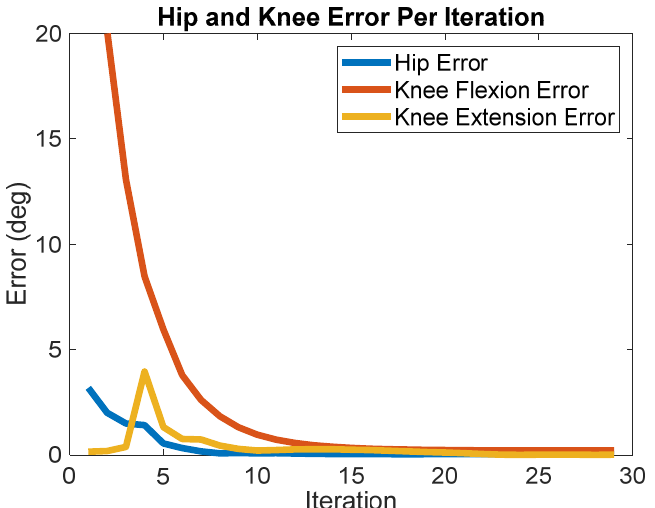
Figure 2. Absolute terminal error over each iteration (swing phase) for hip and knee flexion and knee extension.